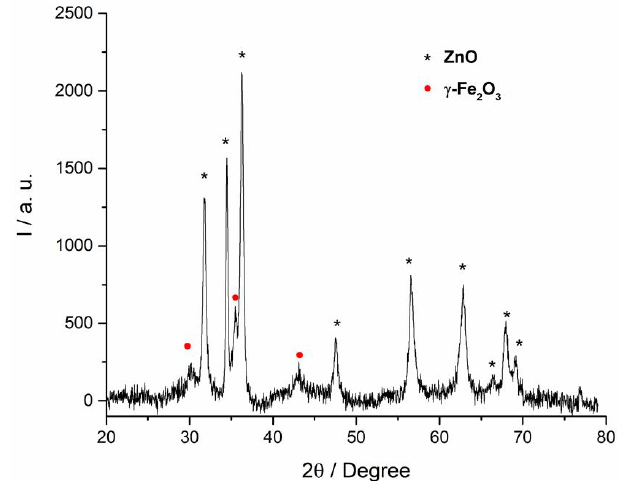
Figure 1. XRD pattern of ZnO/γ-Fe 2 O 3 nanocomposite system. In the graph the peaks related to the ZnO are labeled with black stars and the peaks imputable to the maghemite are indicated with red circles.